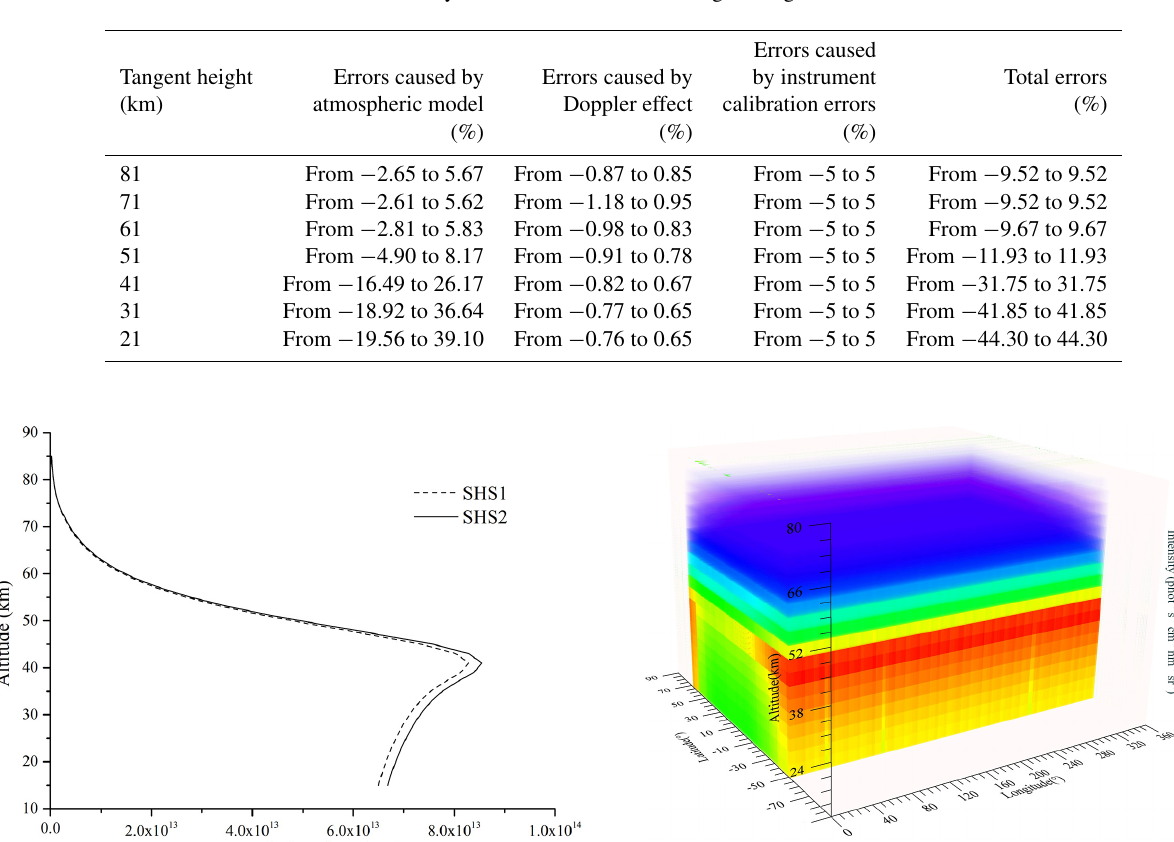
Figure 8. Emulated two-dimensional observed radiance interferogram. Table 3. Total errors in observed radiance caused by different factors at some tangent heights.